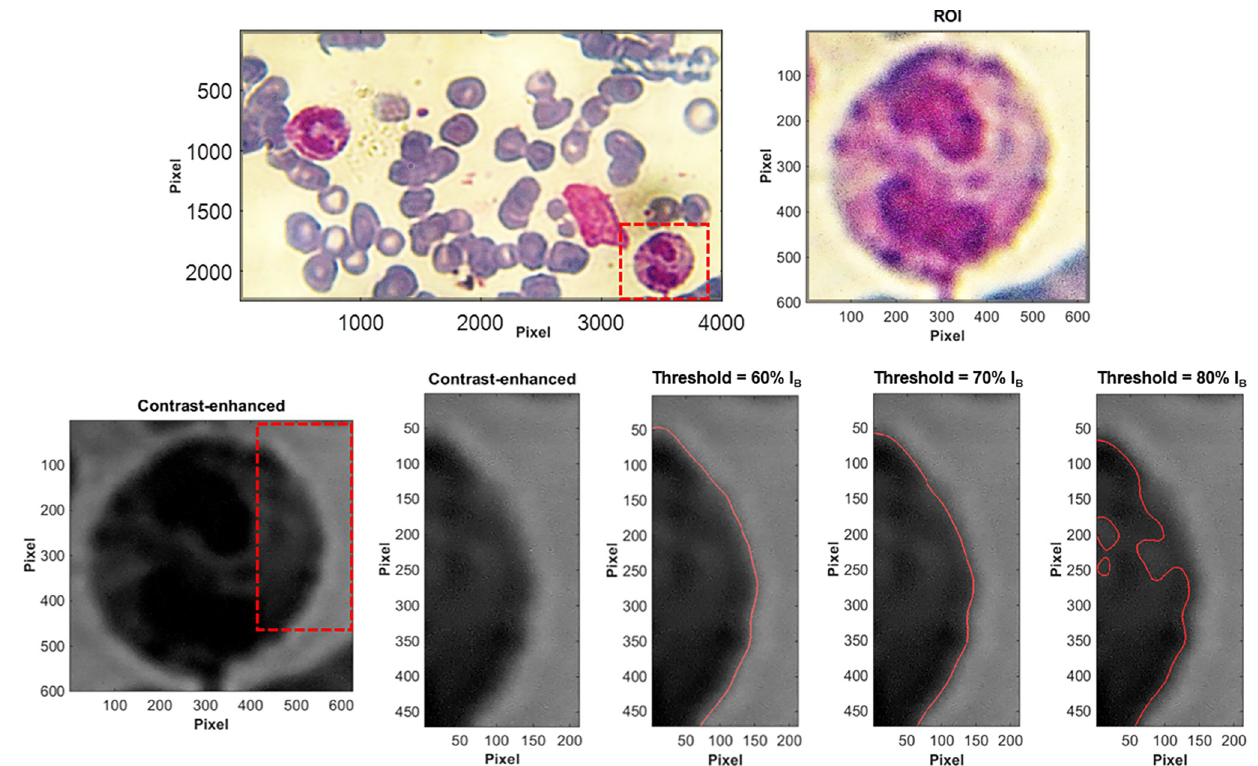
Fig 3. Demonstration of the influence of the threshold in the image processing